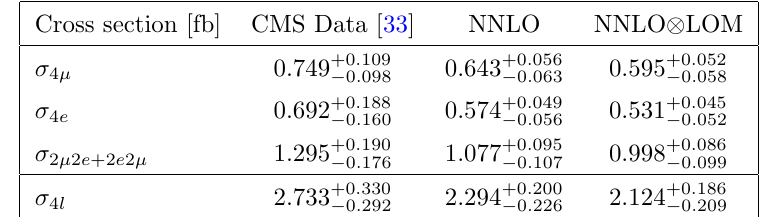
Table 3. The fiducial cross section of Higgs boson production measured in the four-lepton final state using CMS fiducial cuts listed in table 1. The decay channels of 2 e 2 µ and 2 µ 2 e are not distinguished. Experimental uncertainties are statistical and systematic errors combined. Theoretical uncertainties are from scale variation as described in the text.